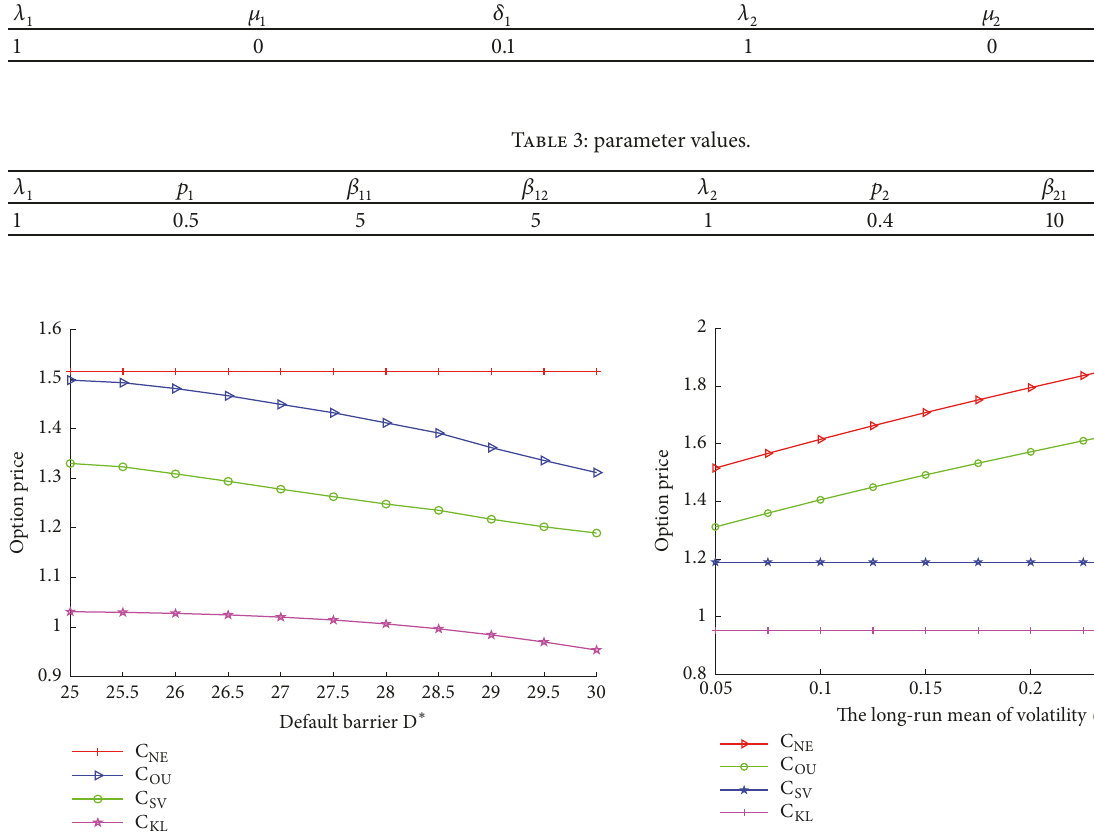
Figure 1: The effect of 𝐷 ∗ on the vulnerable option prices. Figure 2: The effect of long-run mean of stochastic volatility